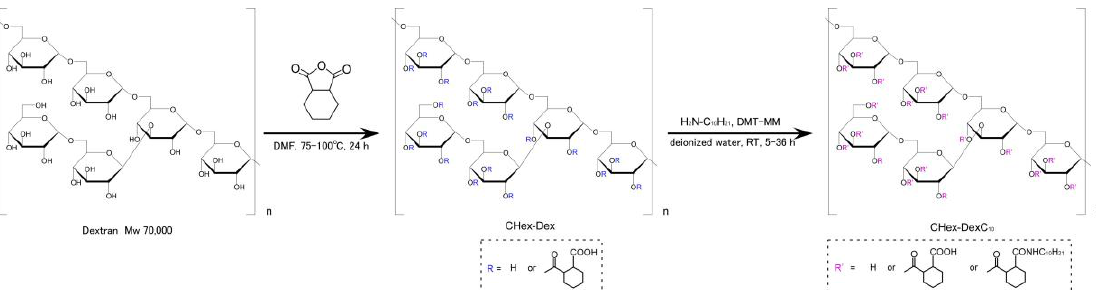
Figure 2. Synthesis of CHex-Dex and CHex-Dex-C 10 . Table 1. Synthesis of CHex-Dex.